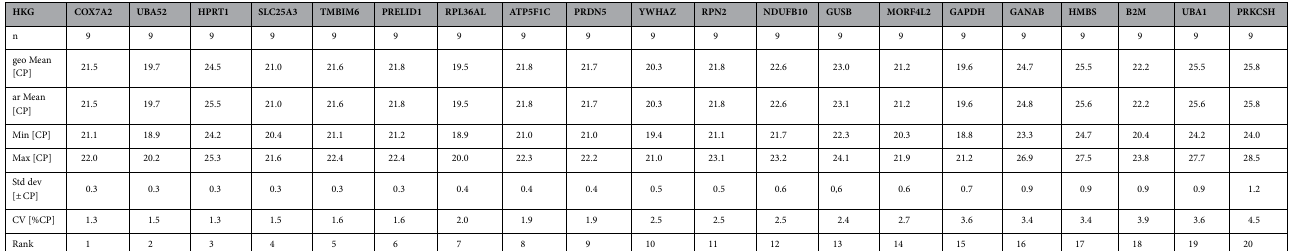
Table 2. Bestkeeper housekeeping gene ranking sorted according to their SD and CV% values and their crossing point (CP)